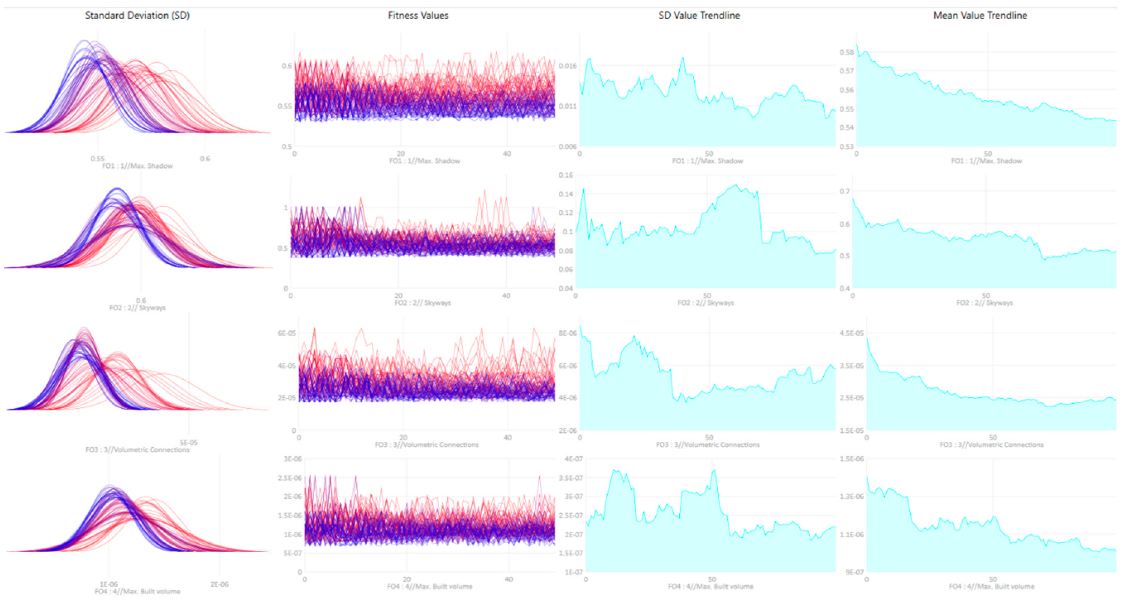
Figure 14. The results of the evolutionary algorithm. Each fitness function was analysed separately across four key metrics (from left to right ): standard deviation, fitness values, standard deviation trendline, and mean value trendline.